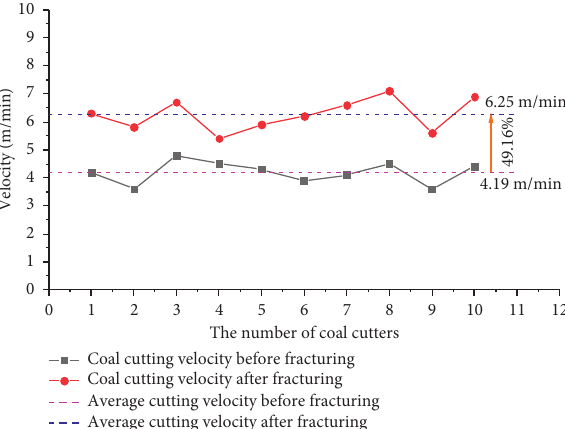
Figure 16: The cutting speed of the coal cutters before and after fracturing of the